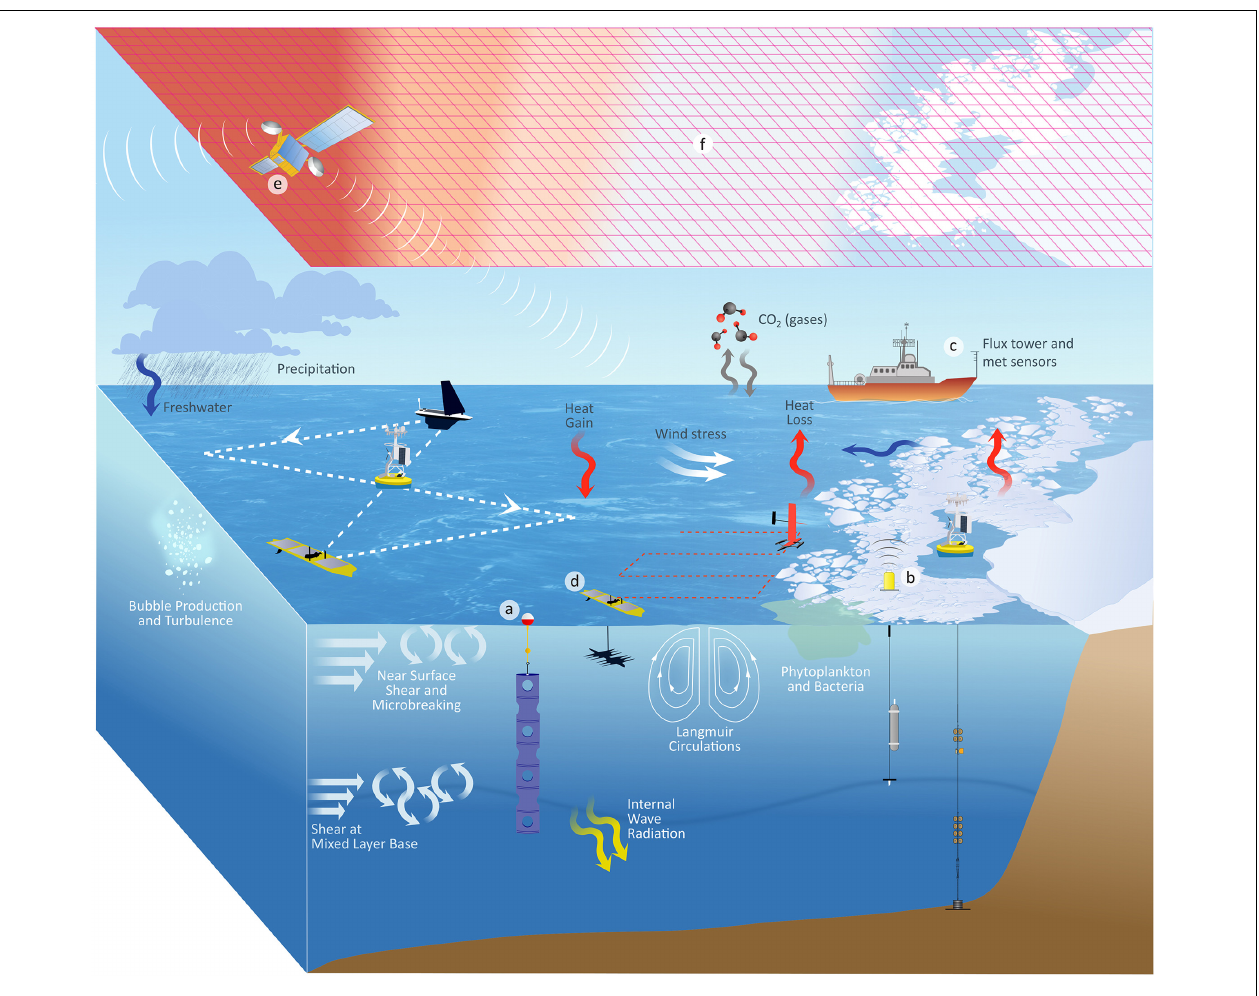
FIGURE 6 | Schematic of the key elements of a Southern Ocean air-sea flux observing system in order to reduce uncertainties in air-sea and air-sea-ice fluxes of heat, momentum, freshwater, and carbon (section “Reducing Uncertainties in Air-Sea and Air-Sea-Ice Fluxes of Heat, Momentum, Freshwater, and Carbon”). The optimal observing system would include buoys (a) in the open ocean, and ice-tethered profilers (b) in the marginal ice zone, as well as ships instrumented with flux covariance systems (c) . Autonomous surface systems (d) such as wave gliders and saildrones are proposed to provide a more extensive spatial network of flux sensors than enabled by ships and buoys alone and also for targeted process studies aimed at understanding air-sea flux variability across fronts or eddies, possibly surveying in the vicinity of a buoy. Satellite measurements (e) of surface wind, SST, and near surface variables provide global measurements that can fill spatial gaps between in situ observations. The grid overlaying the entire domain (f) is intended to indicate the role of assimilating models, such as reanalyses, in ingesting all available observations to provide a consistent gridded flux product. Modified from Meredith et al.